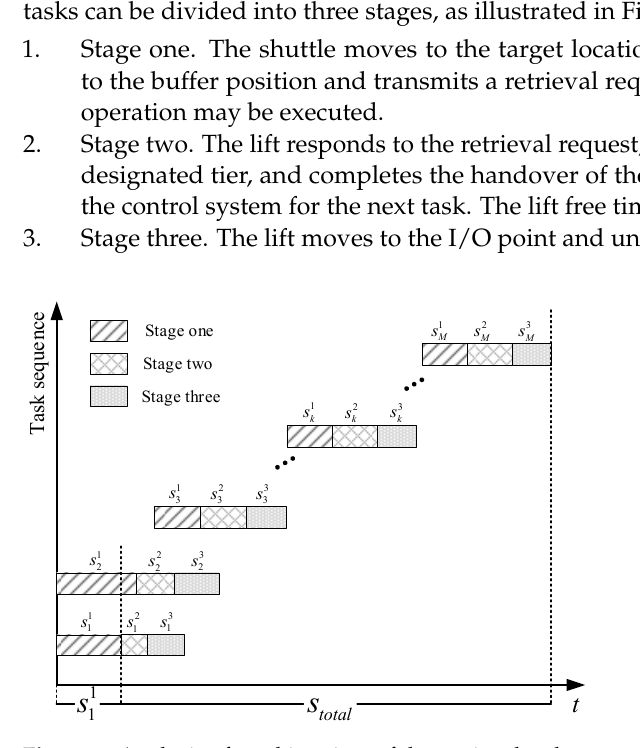
Figure 5. Analysis of working time of the retrieval tasks as a whole. According to the aforementioned analysis and Figure 5, the entire operation process of retrieval tasks is regarded as a flow-shop scheduling problem in parallel machines